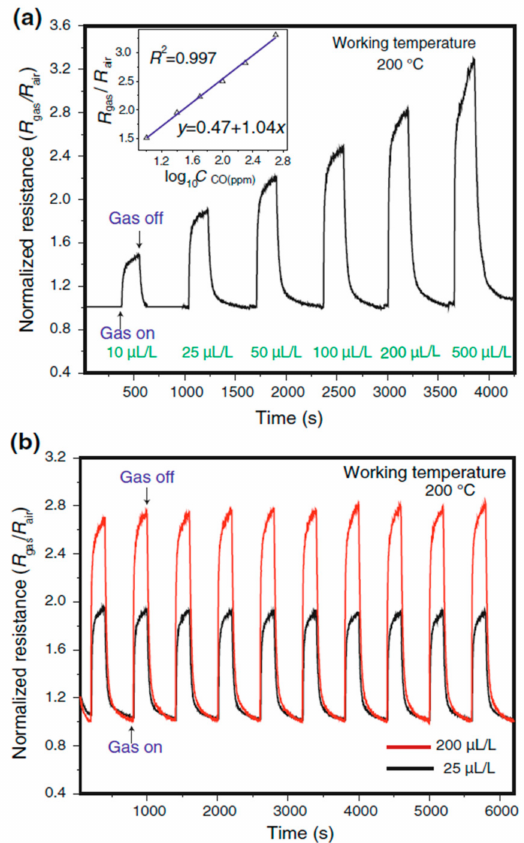
Figure 24. ( a ) Response of Cu 2 O/Au/CuO sensor towards different concentrations of CO gas at 200 ◦ C; the inset figure is the plot of Rgas/Rair as a function of the CO concentration; ( b ) Repro- ducibility of the sensor on (10 cycles) to 25 against 200 µ L/L CO. Reprinted from Ref. [209] with permission of Springer Science Business Media, LLC,